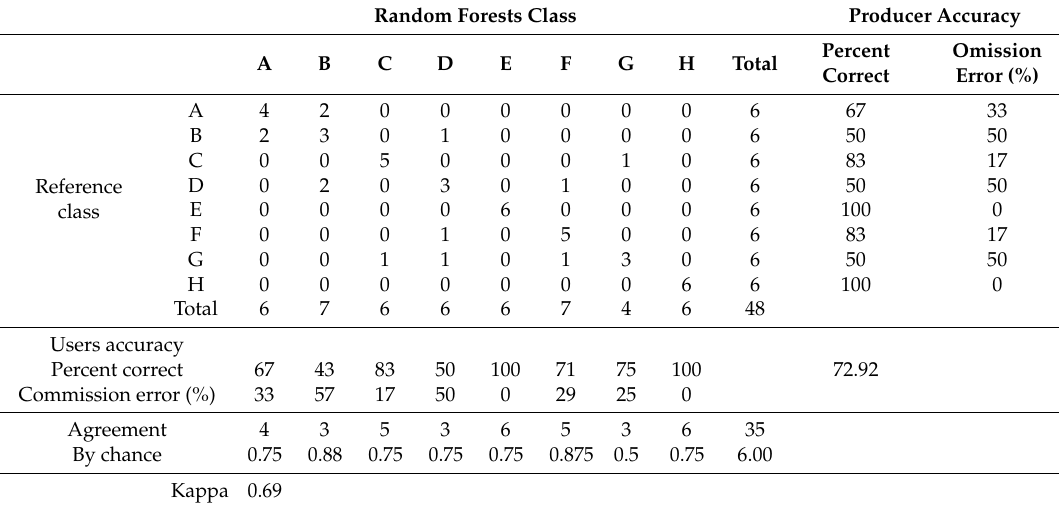
gaharu samples of different